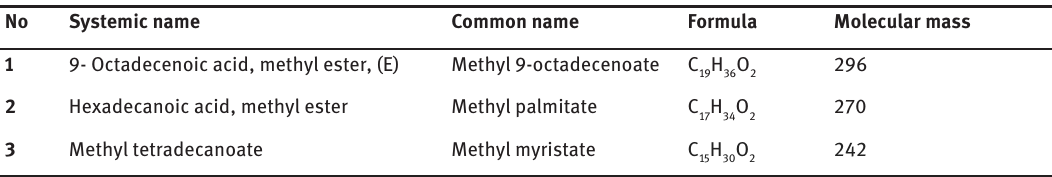
Table 1 : GC-MS analysis of sample product using calcined eggshell as the